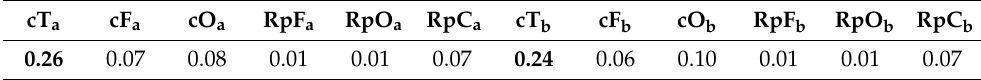
Table 10. Feature_importance values returned by the Random Forest regressor on the different input variables. Values sum to 1. Refer to Table 4 for the description of variables. The variable with highest weighting (total fruit count) is shown in